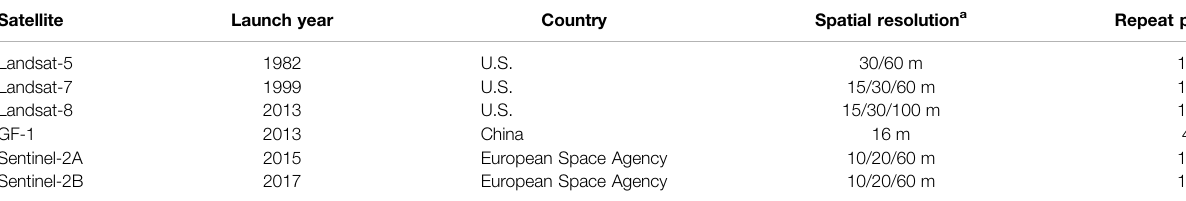
TABLE 1 | Parameters of Landsat satellite, GF-1 satellite, and Sentinel satellite.